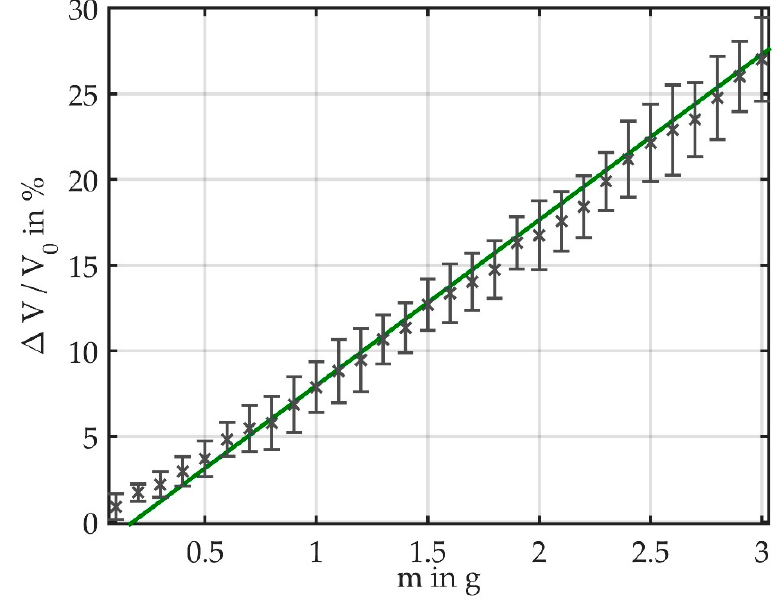
Figure 7. Measurement results showing that the light loss relative to the reference voltage depends linearly on the bending mass. The average measurement results including error bars for bending masses of 0 g to 3 g are shown.